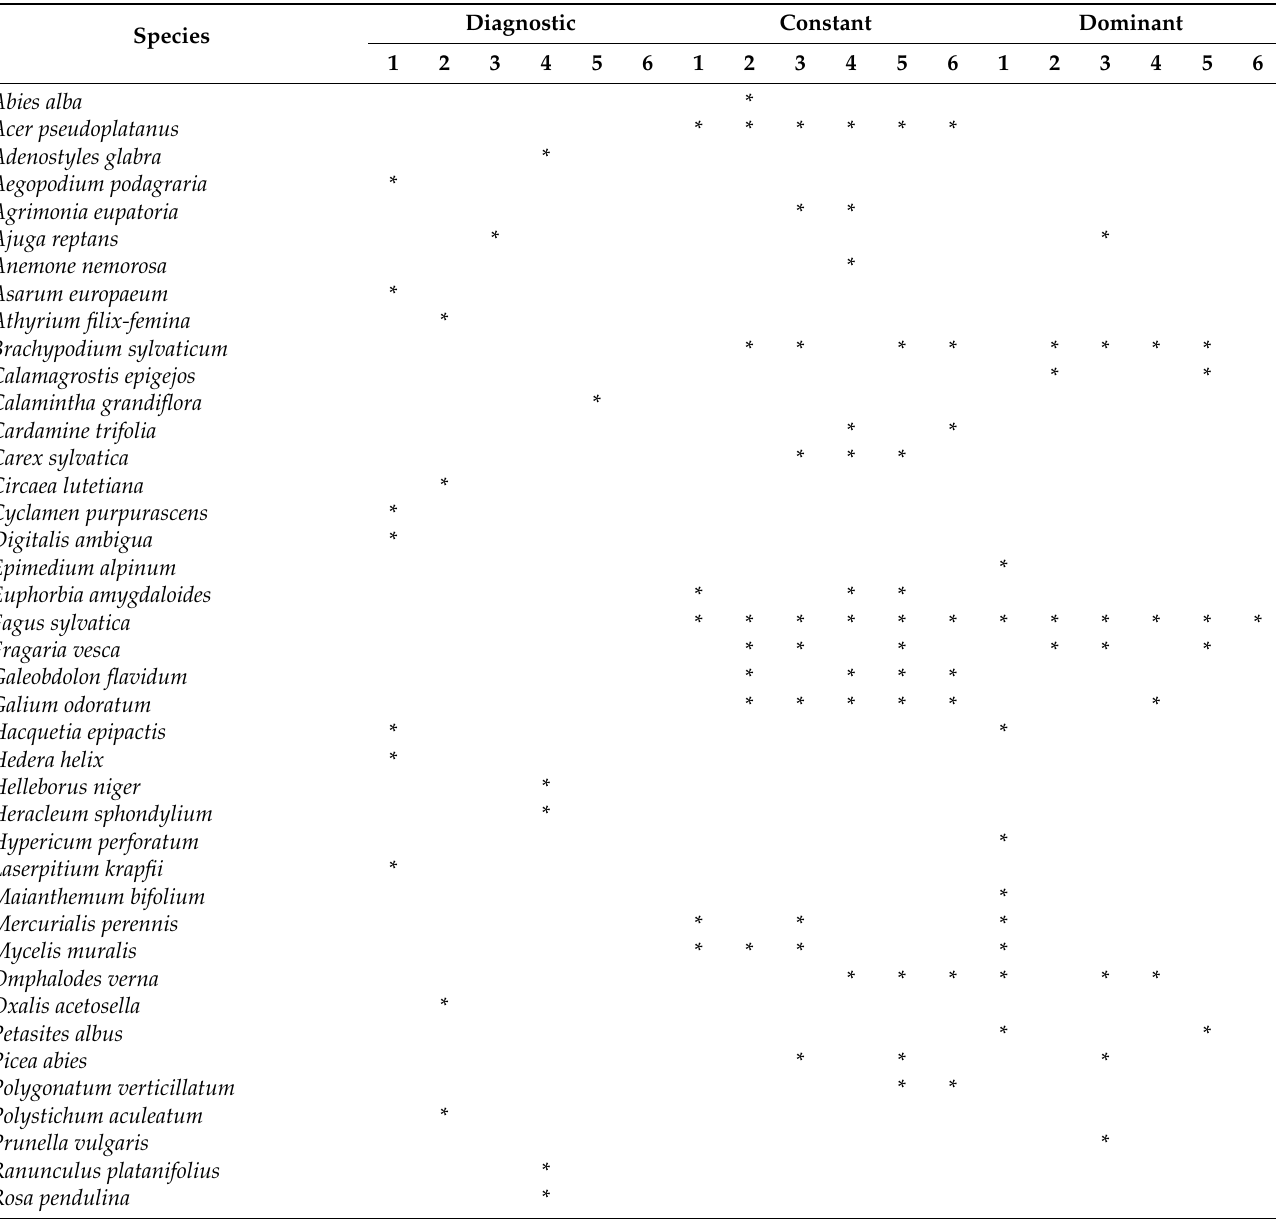
Table 4. Diagnostic, constant, and dominant plant species on the studied forest gaps (1: L6-2014,